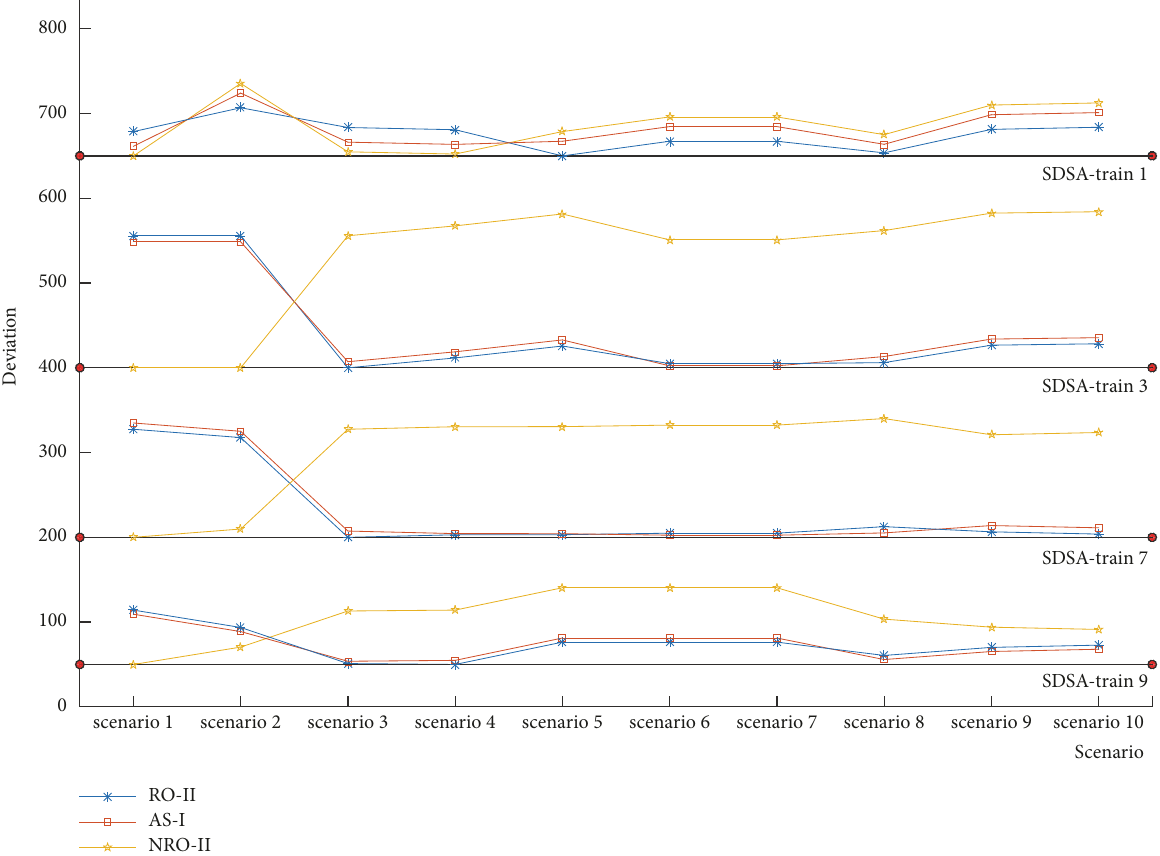
Figure 8: The deviation between the three sets of contrast experiments and each scenario.